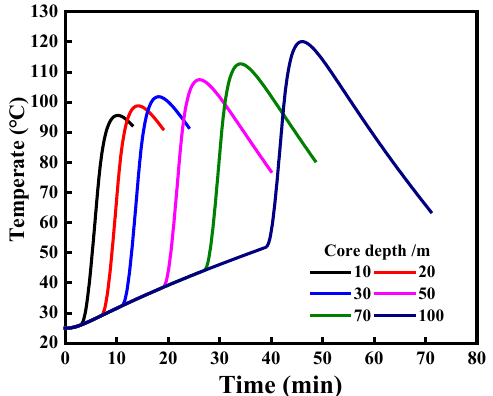
Figure 20. Temperature variations of measuring point during coring at different core depths in ZG.